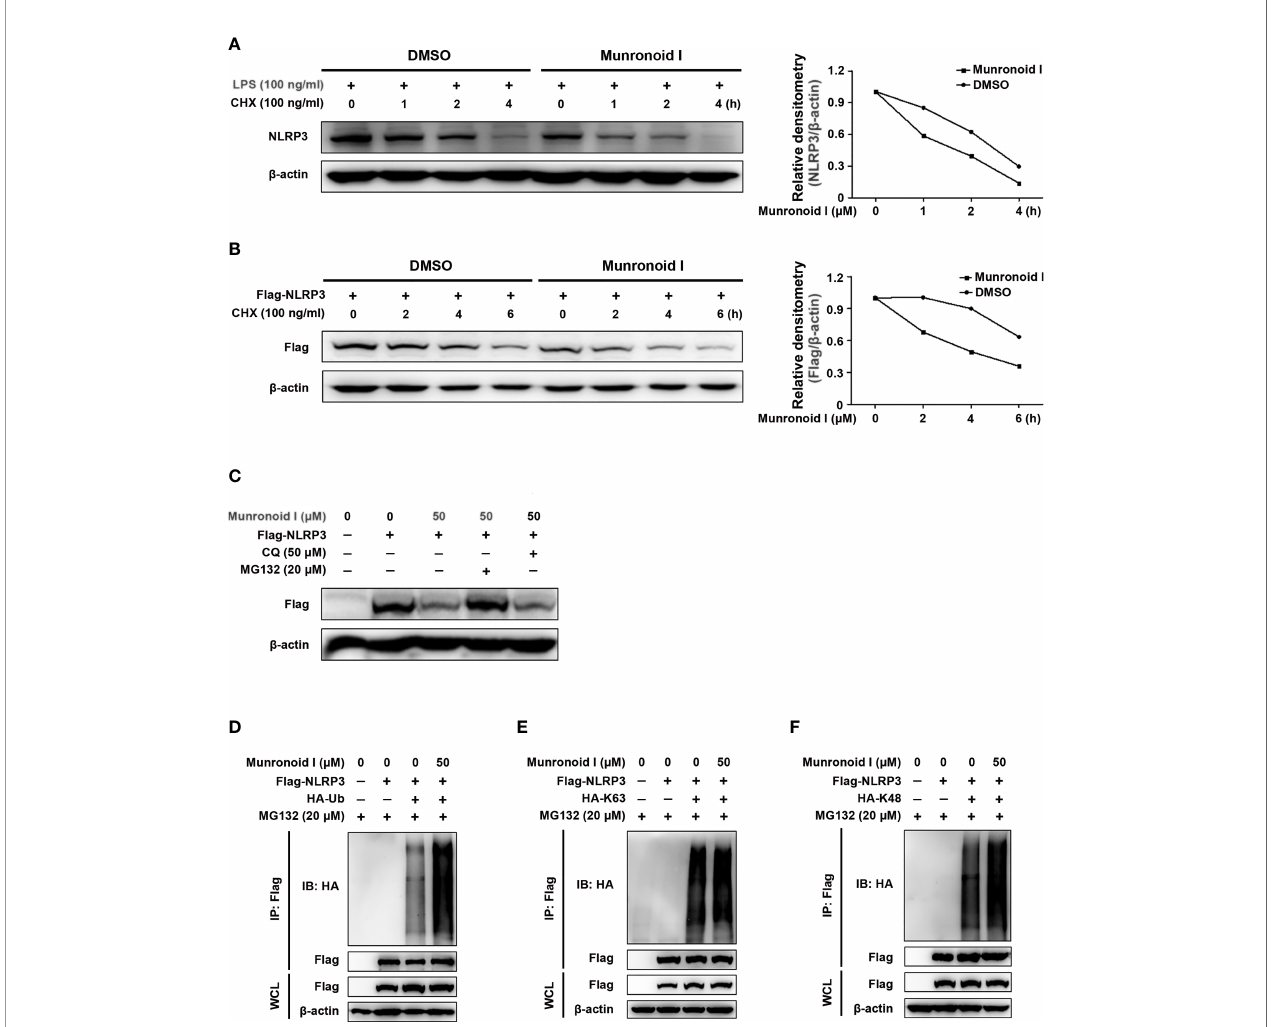
FIGURE 7 | Munronoid I promotes the K48-linked ubiquitination and proteasomal degradation of NLRP3. (A) Mouse peritoneal macrophages were treated with DMSO or Munronoid I (50 m M) for 4 h and stimulated with CHX (100 ng/ml) for indicated hours, following NLRP3 was detected by Western blot. (B) Plasmid encoding Flag-NLRP3 was transfected into HEK293T cells. The cells were treated with DMSO or Munronoid I (50 m M) for 6 h and stimulated with CHX (100 ng/ml) for indicated hours, following Flag were detected by Western blot. All the above data were from three independent experiments. (C) Plasmid encoding Flag-NLRP3 was transfected into HEK293T cells. The cells were treated with DMSO or Munronoid I (50 m M) and MG132 (20 m M) or CQ (50 m M) for 5 h, Flag was detected by Western blot. (D – F) Plasmids encoding Flag-NLRP3 and HA-Ub/HA-K48/HA-K63 were co-transfected into HEK293T cells for 24 h. Cells were treated with DMSO or Munronoid I (50 m M) and MG132 (20 m M) for 5 h. Cells were harvested for Western blot analysis of HA-Ub (D) or HA-K63 (E) or HA-K48 (F) immunoprecipitated with antibody to Flag tag. All the above data were from three independent